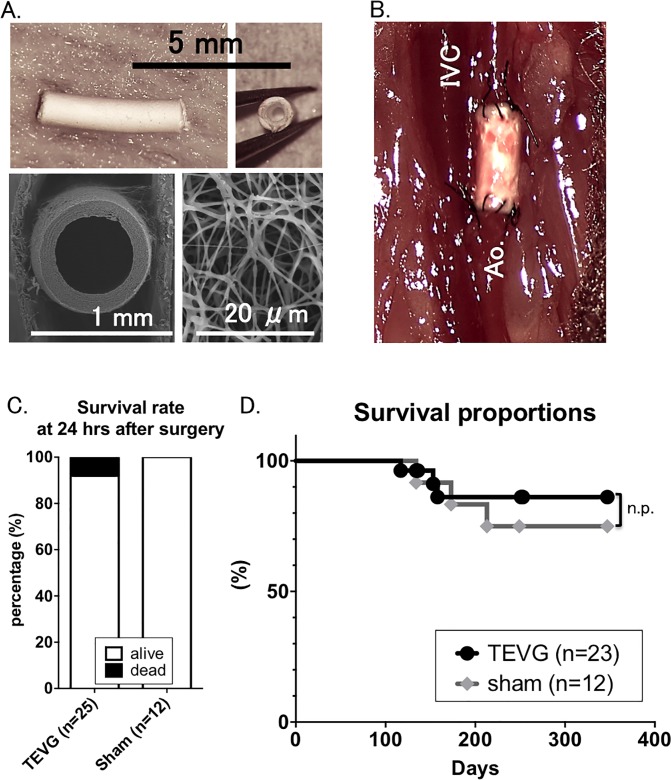
TEVG implantation was successful as indicated by a similar survival rate at 12-month post-operation in TEVG group to sham group.A. Structure of TEVG. Implanted TEVG was composed of biodegradable electrospun polylactic acid (PLA) nanofibers with a length of approximately 3mm and inner luminal diameter 500–600 μm. Scanning electron microscopy demonstrates macro- and micro-arrangement of graft. B. TEVG after surgical implantation (IVC: inferior vena cava; Ao: aorta). C. Survival rate at 24 hours after surgery. 25 TEVGs were implanted in C17SCID/bg mice. 12 syngeneic mice underwent sham operations. >90% of mice implanted with TEVG survived 24 hours after TEVG implantation. Peri-operative mortality was due to bleeding or thrombosis. D. Kaplan-Meier survival curve during the 12 months of experiment. Similar survival rate was seen between two groups over the course of 12 month-experiment.